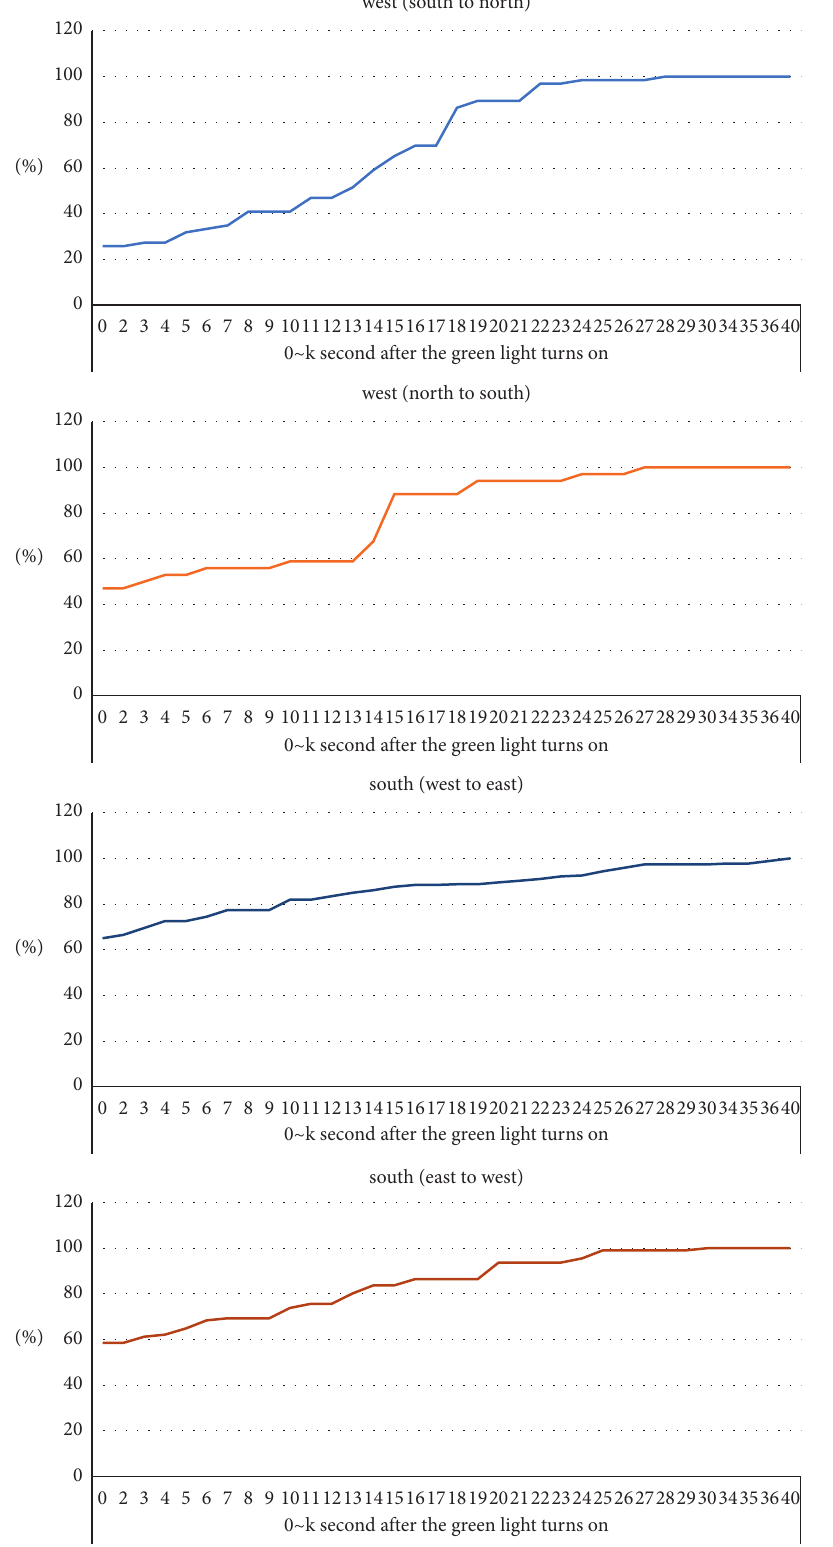
Figure 5: Time distribution of pedestrians in four directions ( Y -axis: the proportion of pedestrians crossing the